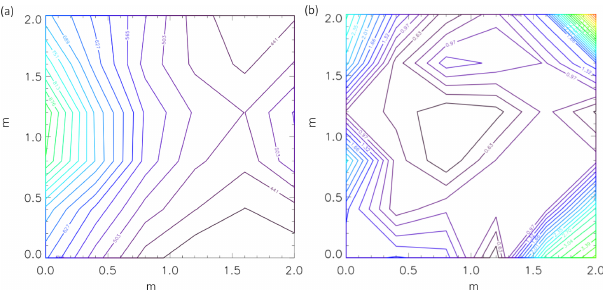
Figure 2. Geant 4 simulations of ionization rate, q [cm − 3 s − 1 ], in the chamber with 0cm (a) and 8.5cm (b) lead shielding. The aver- age ionization for the entire chamber is presented in Table 1. Table 1. Average ionization rate for the entire chamber ( q ) achieved with the gamma sources at various thicknesses of lead shielding calculated with Geant 4. N is the ion density including the ions produced by naturally occurring radiation. Shielding thickness